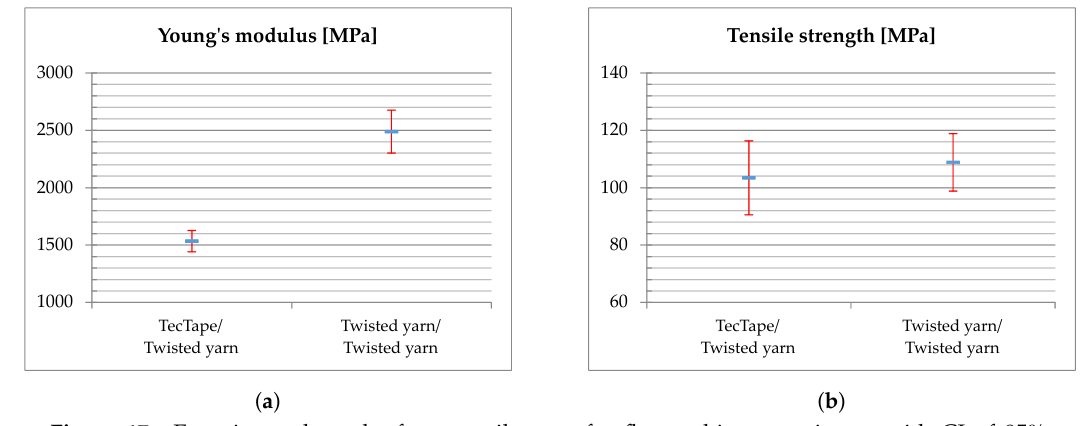
Figure 17. Experimental results from tensile tests for flexure hinge specimens with CI of 95%: ( a ) Young’s modulus. ( b ) Tensile